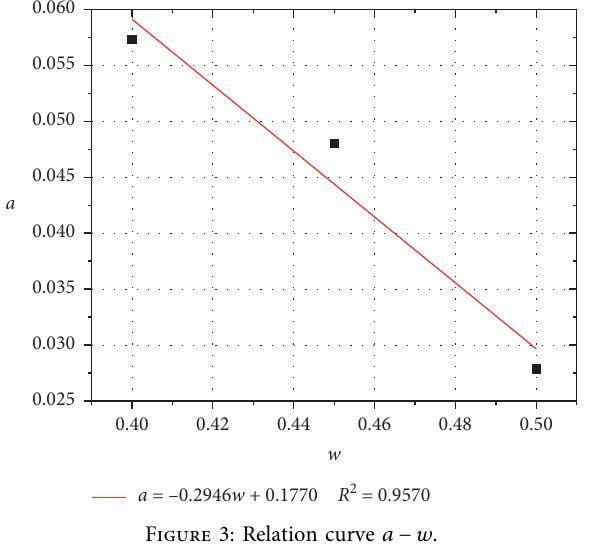
Figure 3: Relation curve a − w